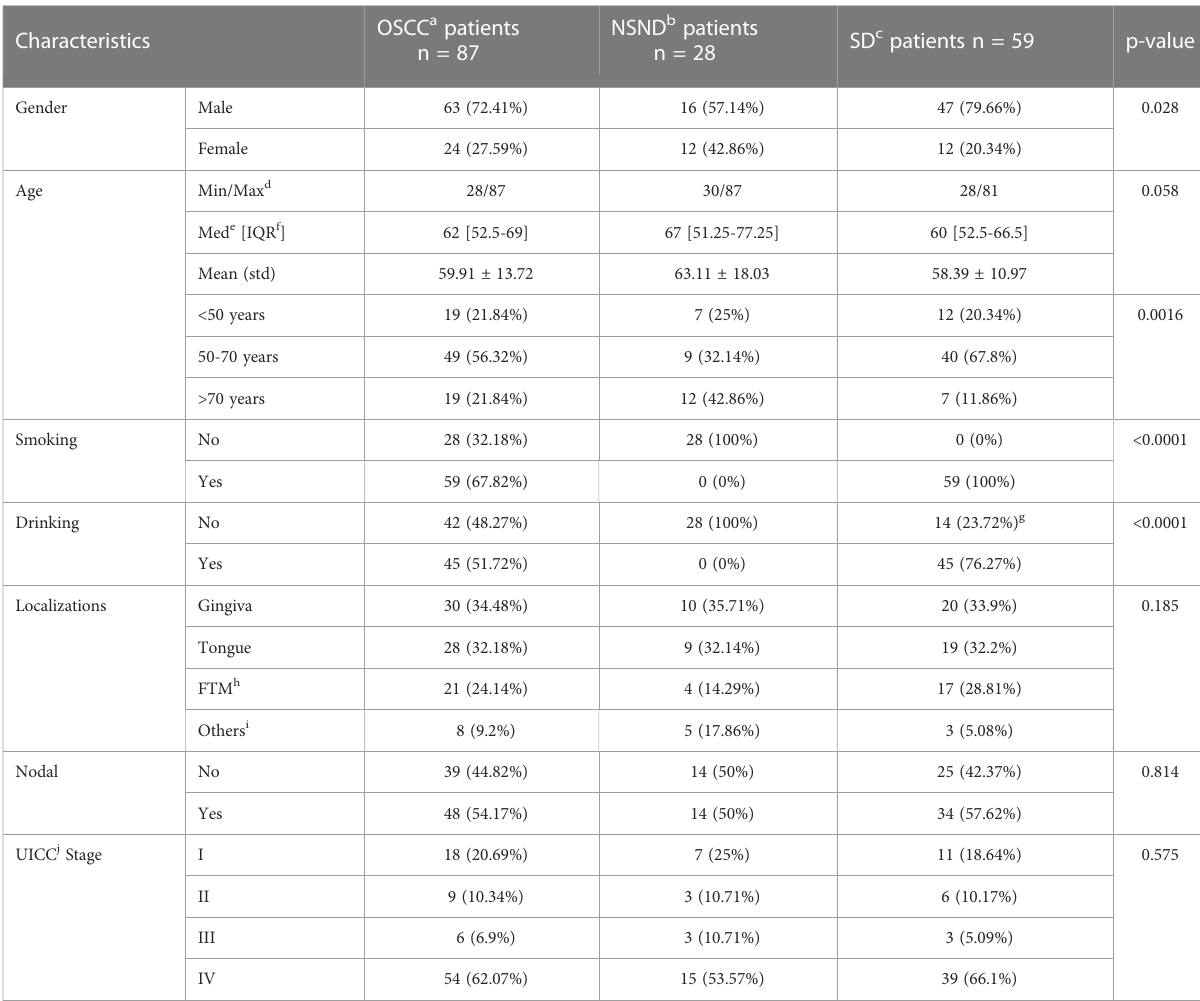
TABLE 1 Clinical features of OSCC patients and differences between NSND and SD OSCC patients.